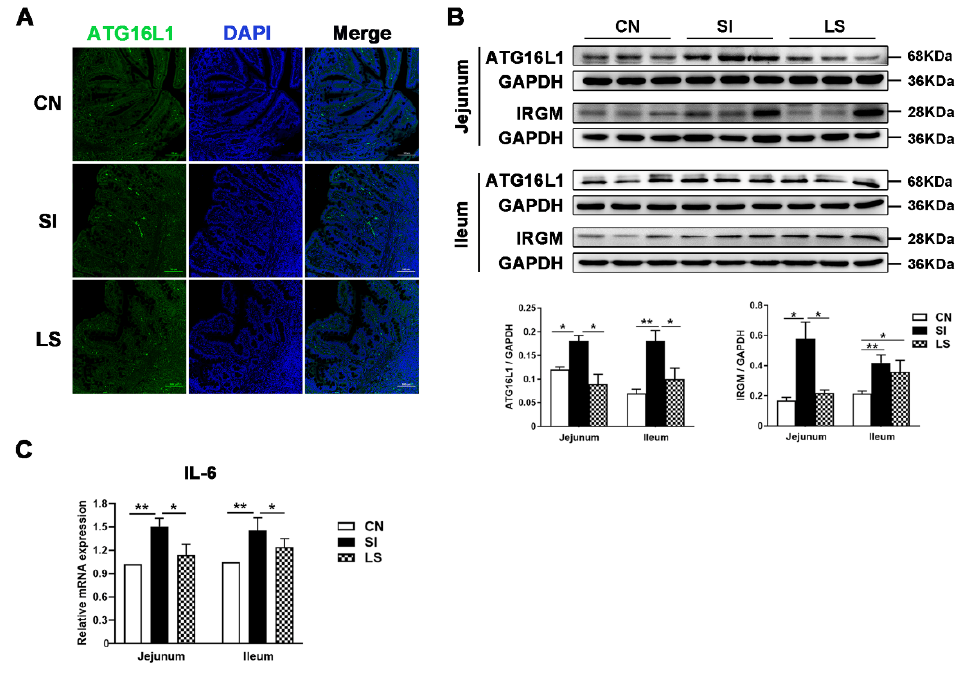
Figure 2. Oral L. johnsonii L531 attenuates the S. Infantis-induced jejunal and ileal autophagy. ( A ) Confocal micrograph illustrating the accumulation of ATG16L1 (Green) in the jejunum of pigs challenged with S. Infantis or L. johnsonii L531. Blue: DAPI. Scale bar, 100 µ m. ( B ) Western blotting analysis for ATG16L1and IRGM in the jejunum and ileum from piglets 10 days after S. Infantis challenge. The right panels show the protein quantitation using Image J software. ( C ) Expression of Il 6 mRNA in jejunal and ileal tissues from uninfected, S. Infantis-infected, and L. johnsonii L531 pretreated piglets on day 18. Data are represented as mean ± SEM, n = 6; * p < 0.05, ** p < 0.01.